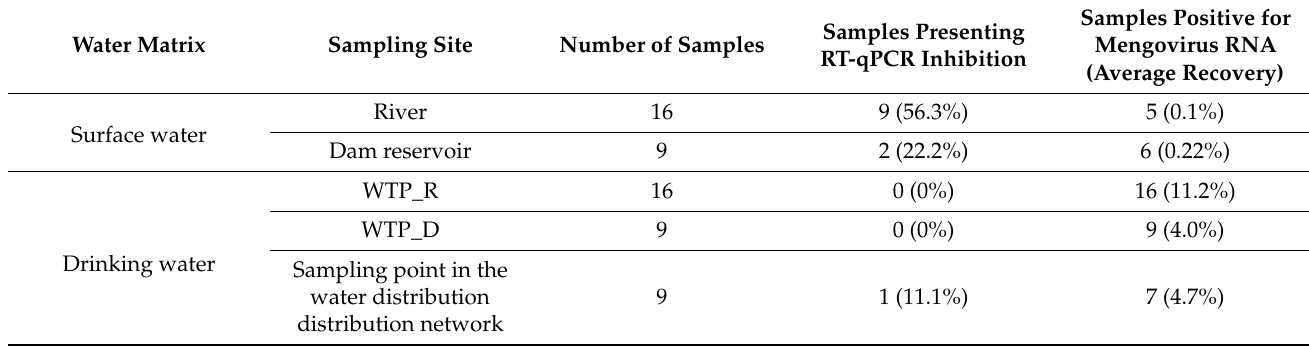
Figure 1. Mengovirus recovery rates and levels of water concentration, over the 2019 sampling campaign (addition of mengovirus during the filtration/primary concentration step), for the water collected at the five sampling points: ( A ) River ( n = 16); ( B ) Dam reservoir ( n = 9); ( C ) WTP_R ( n = 16); ( D ) WTP_D ( n = 9); ( E ) Sampling point in the distribution network ( n = 9). The asterisks point to the three samples evaluated (and positive) for mengovirus infectivity. Table 2. Data regarding the samples collected in the 2019 sampling